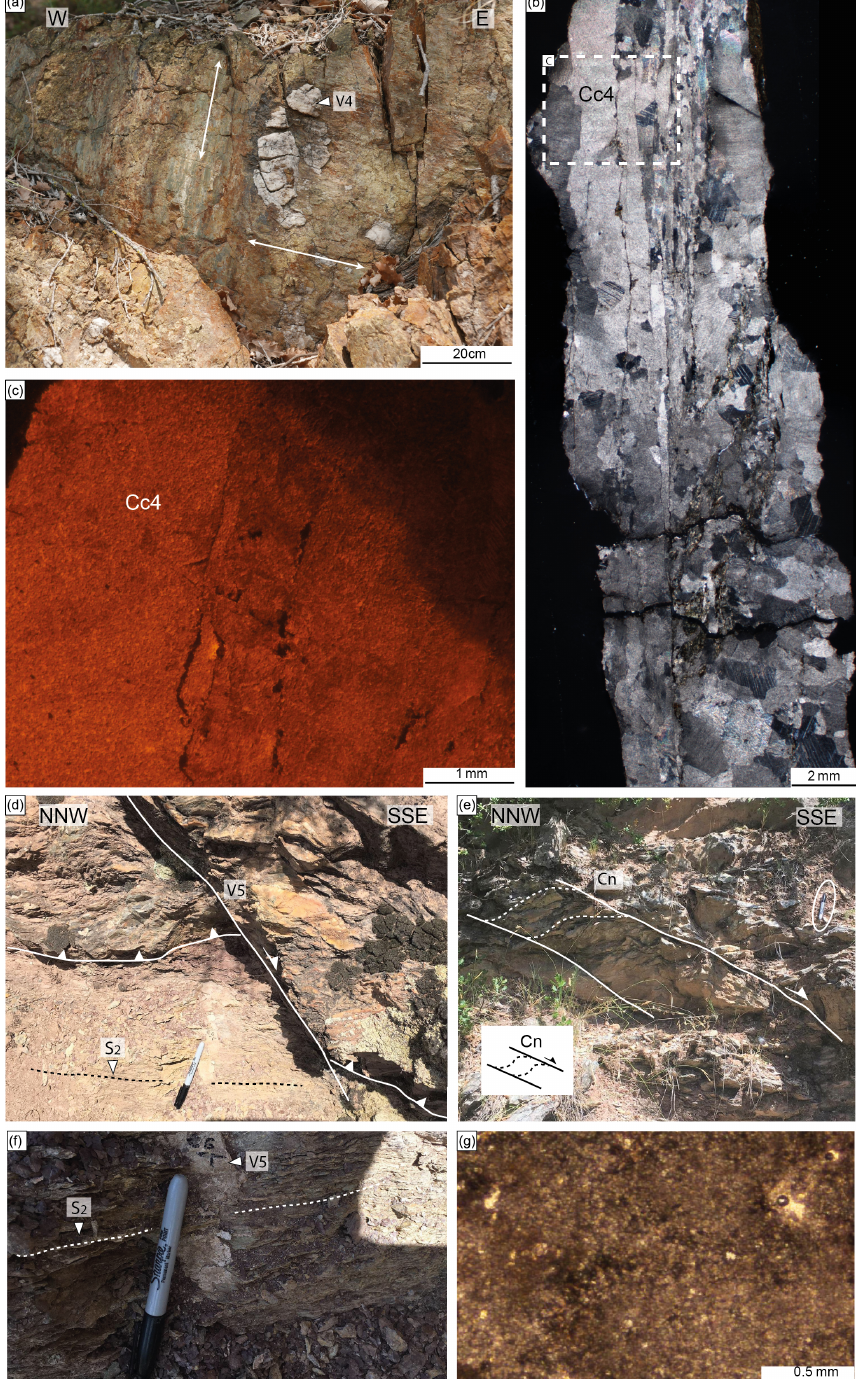
Figure 8. (a) Field image of a subvertical and E–W fault plane mineralized with calcite (veins V4) and showing two striae set generations (white arrows) indicating dip-slip and strike-slip kinematics. (b) Cross-polarized light and (c) cathodoluminescence microphotographs of the vein-related calcite cement (Cc4). (d) Shear fracture postdating the thrust zone foliation, locally mineralized with calcite veins V5. (e) Shear bands (Cn) with normal kinematics located in the main thrust zone, indicating a later reactivation of the Estamariu thrust. (f) Field image of a calcite vein V5 and (g) plane-polarized light of the vein-related cement